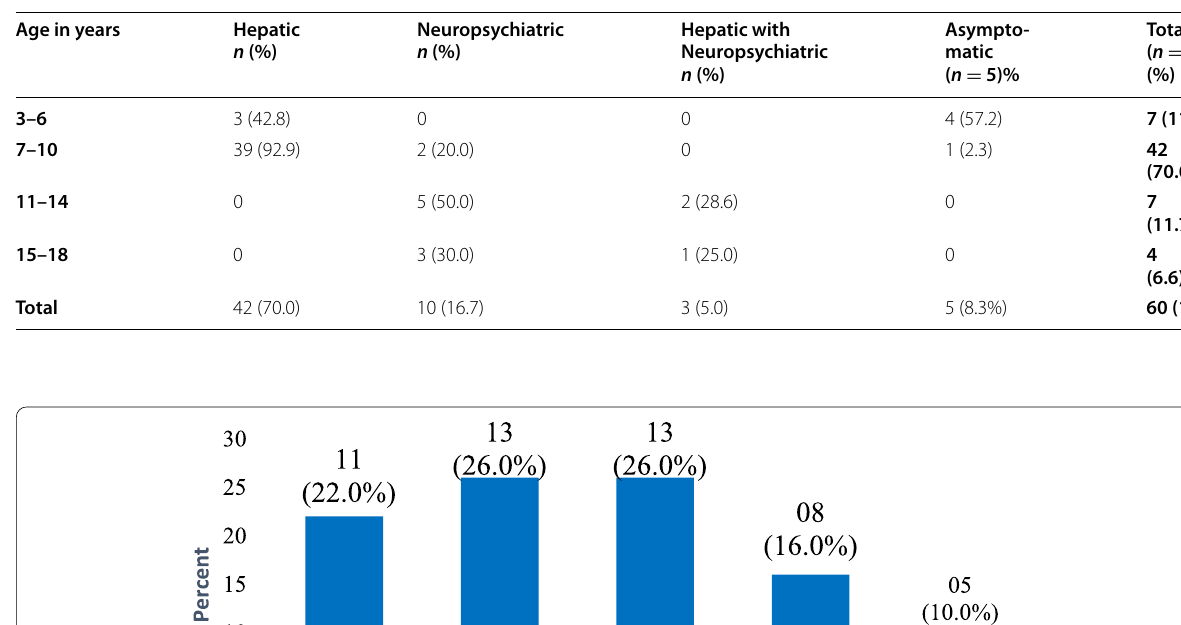
Table 1 Age distribution of the studied children ( n